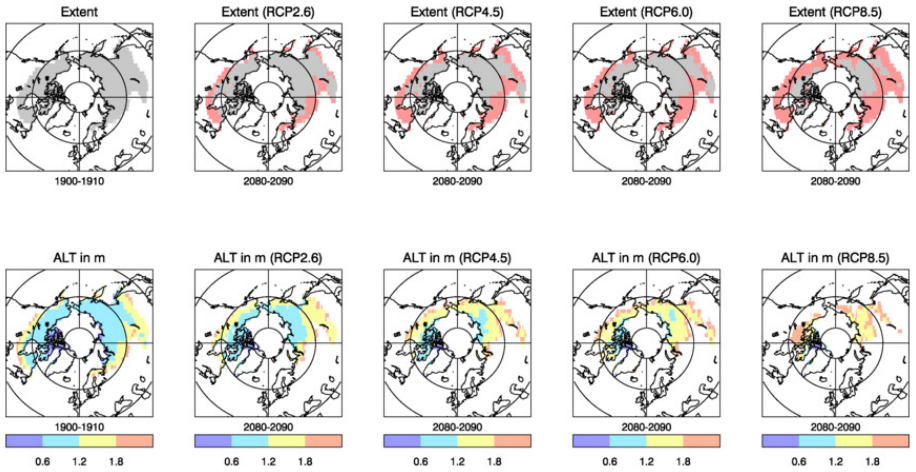
Fig. 3. Mean permafrost extent and active layer thickness (ALT) for 1900–1910 and for 2080–2090, modelled by HadGEM2-ES for the four Figure 3. Mean permafrost extent and active layer thickness (ALT) for 1900-1910 and for RCP pathways. In the plots of permafrost extent (top row), the red shows the places where there is no longer permafrost in the top 2080-2090 modelled by HadGEM2-ES for the four RCP pathways. In the plots of permafrost extent (top row) the red shows the places where there is no longer permafrost in the top 3 m.